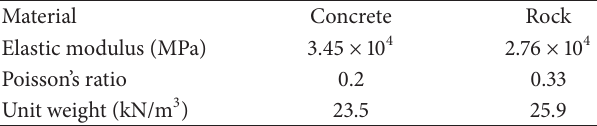
Table 1: Material